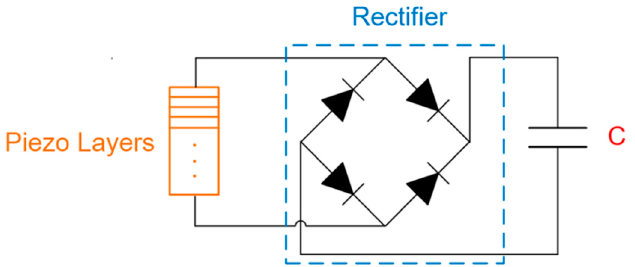
Figure 9. Schematic diagram of the charging circuit.